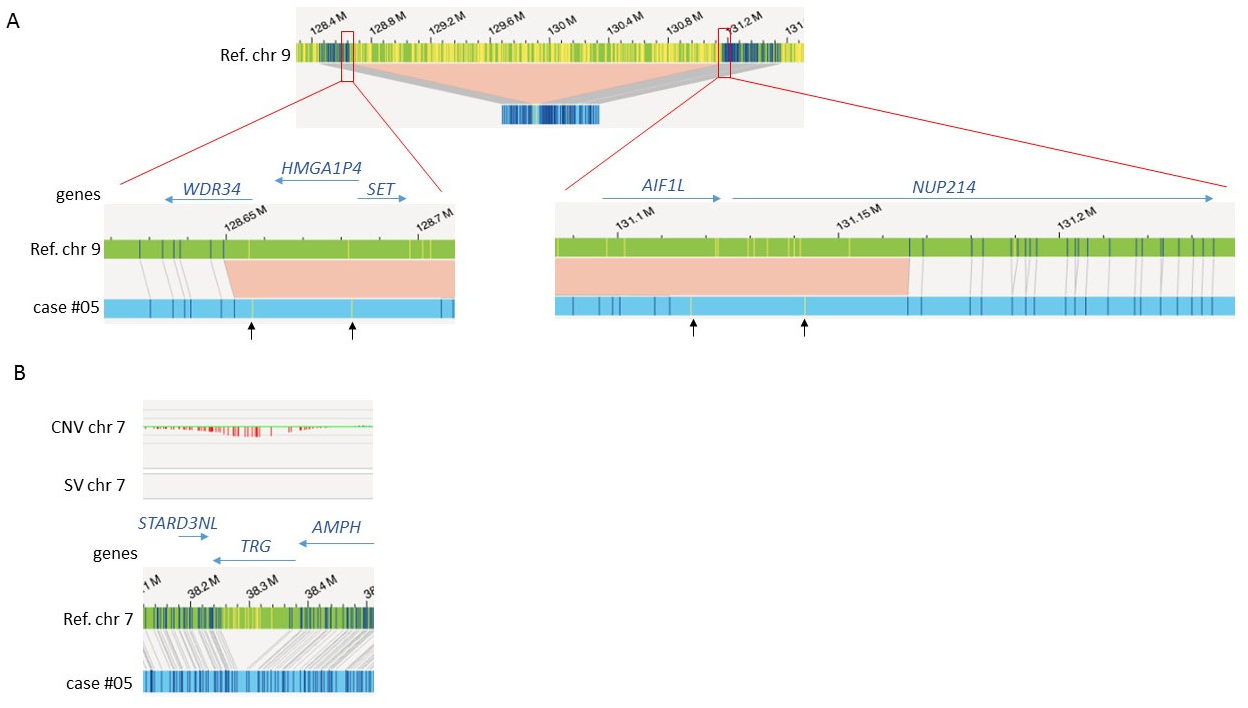
Figure 5. OGM results on case #05. ( A ) OGM detected a 2.46 Mb deletion at 9q34.11-q34.13 (( upper ) figure) but did not identify the SET::NUP214 fusion. Detailed views at the breakpoints (( lower ) figures) depict two labels not aligned to the reference genome (indicated by black arrows) at any of the breakpoints so that the breakpoint at 9q34.11 is incorrectly located in the WDR34 gene. If the two non-aligned labels are considered to align with the reference genome at 9q34.11, the breakpoint should be localized in the SET gene. ( B ) Deletion at the TCR gamma ( TRG ) locus that is not called by the SV or CNV pipelines, although the CNV track shows an inflection corresponding to the